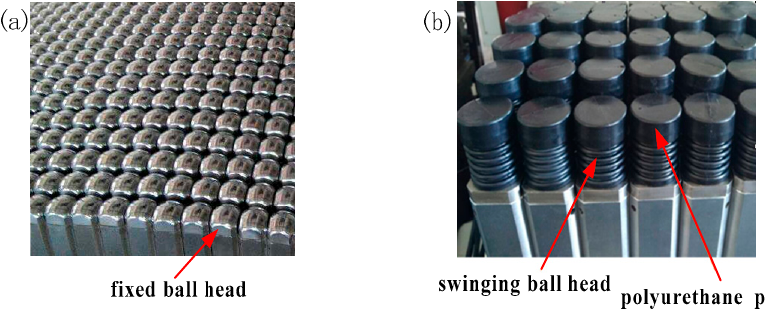
Figure 12. Multi-point dies with fixed ball heads and swinging ball head: ( a ) fixed ball head; ( b ) swinging ball head.